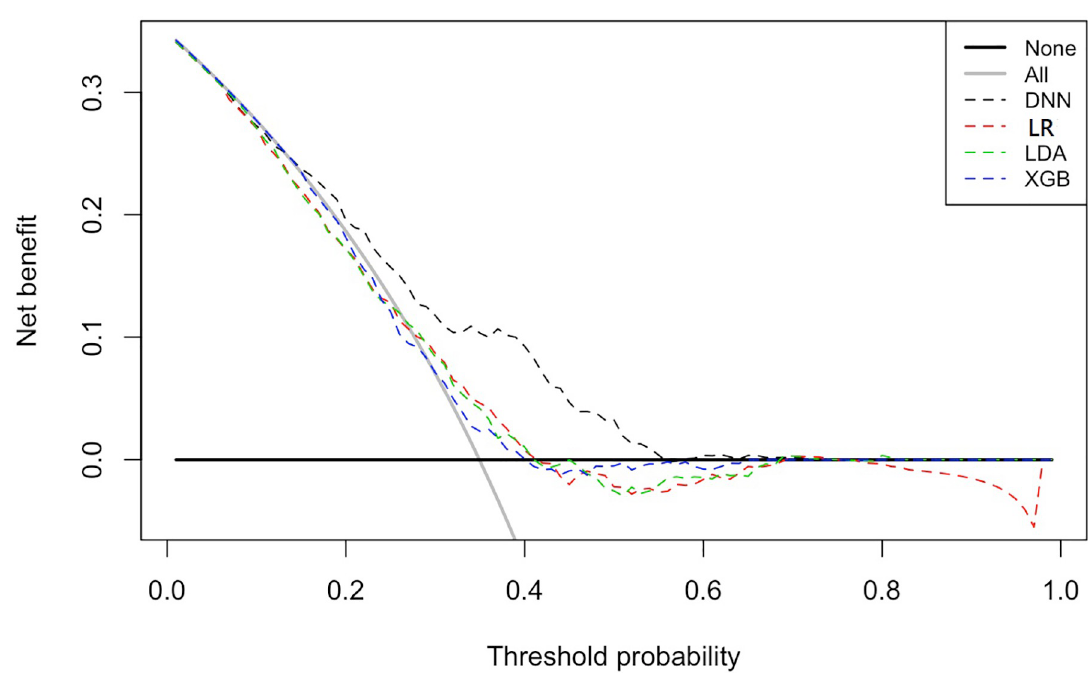
Fig 4. Decision curve analysis. Decision curve analysis allows the variation of threshold probability to examine whether one model is superior to another at a specific range of threshold probability, for the net benefit. This figure indicates that DNN is superior when the threshold is 0.2–0.55. LR; logistic regression, LDA; linear discriminant analysis, XGB; gradient boosting machine, DNN; deep neural network.